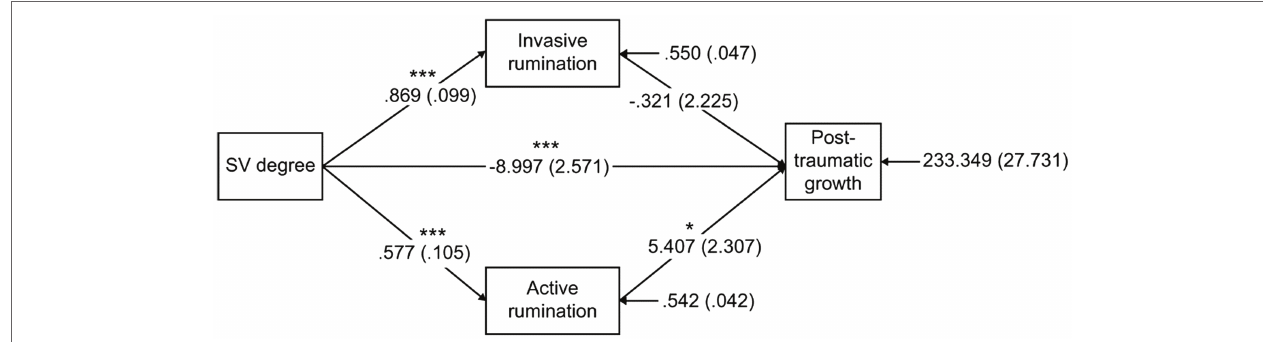
FIGURE 3 | Tests of the dual mediating effect model of active and invasive rumination. For the data on the arrow between variables in the figure, the path estimate coefficients are outside the brackets, and the corresponding standard errors are inside the brackets. For the data with arrows pointing to variables such as active rumination, active rumination and PTG, the corresponding residuals are outside the brackets, and the standard errors are inside the